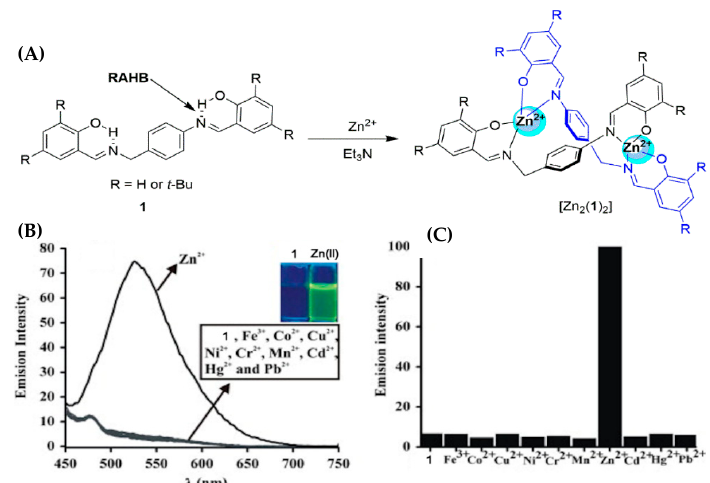
Figure 1. ( A ) The proposed coordination structure (based on the Co 2 + crystal structure) and ( B ) the emission spectrum of compound 1 (DMF 10 µ M and two equivalents of Et 3 N, λ ex 422 nm) and ( C ) bar chart highlights the emission intensity at 527 nm, upon the addition of metal salts (1.2 equivalents). Adapted from [131], with permission from